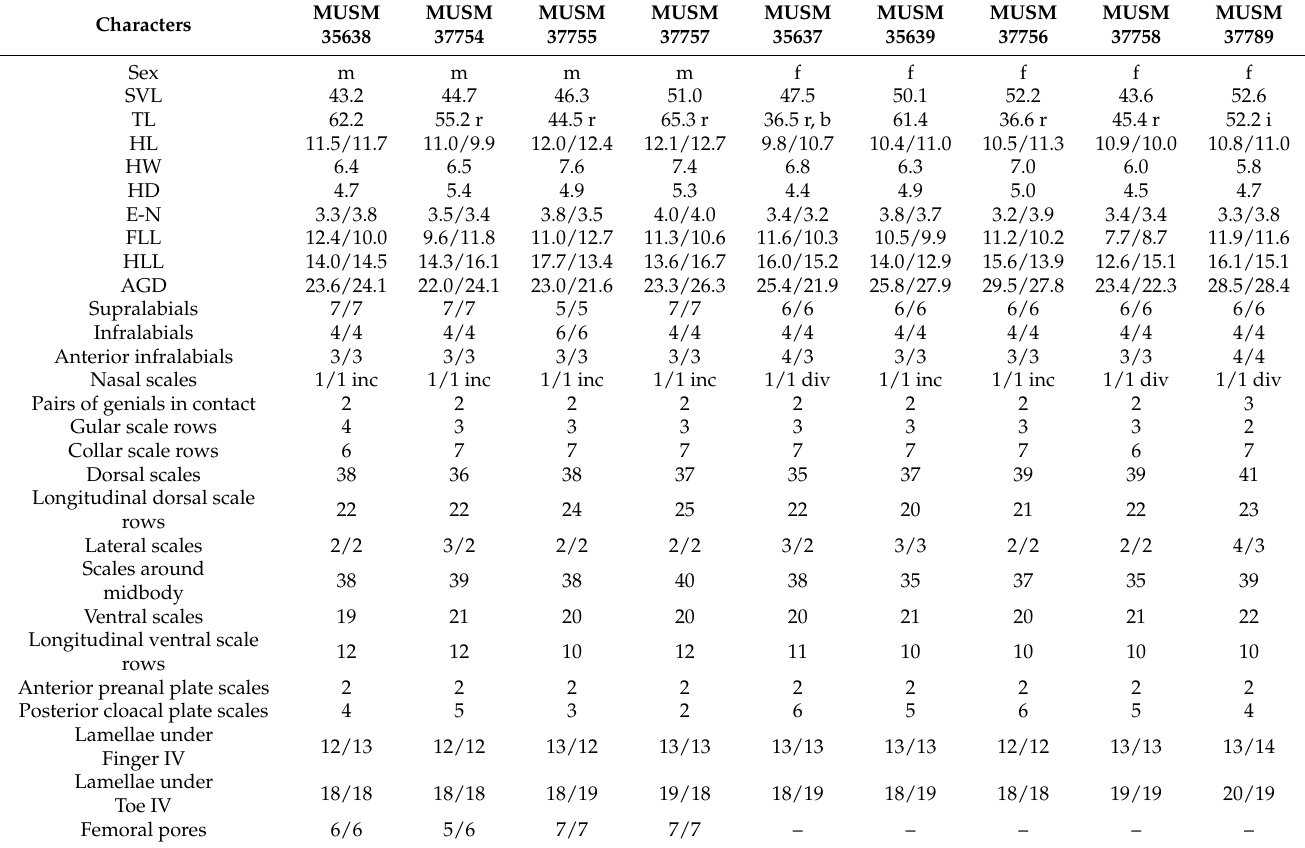
Table A3. Measurements (in mm) and pholidotic characters of referred specimens of adult Proctoporus titans sp. nov. A plus sign indicates the presence of a character, a dash indicates its absence, and a diagonal bar separates counts from the left and right body side. TL condition: b = broken, i = incomplete, reg = regenerated. For other abbreviations see materials and